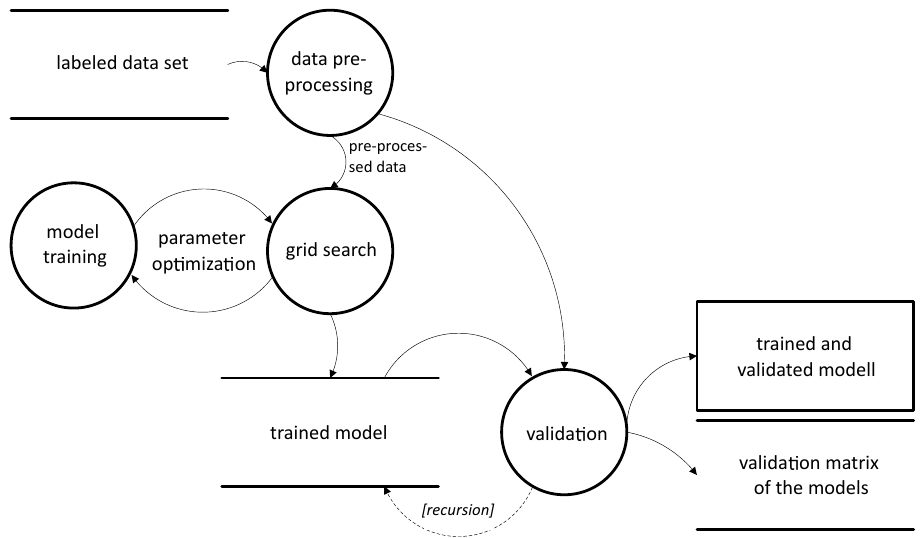
Figure 1. Data-flow diagram for machine-learning approach